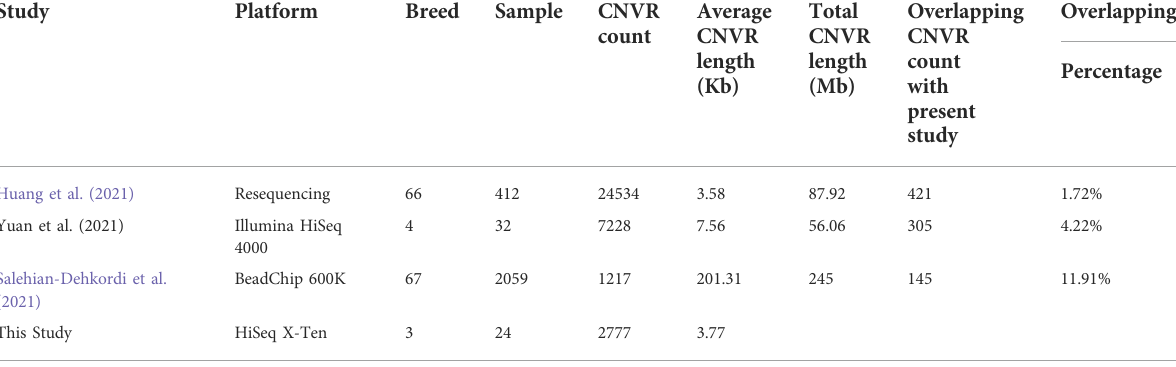
TABLE 2 Comparison of our study with three recent sheep CNV